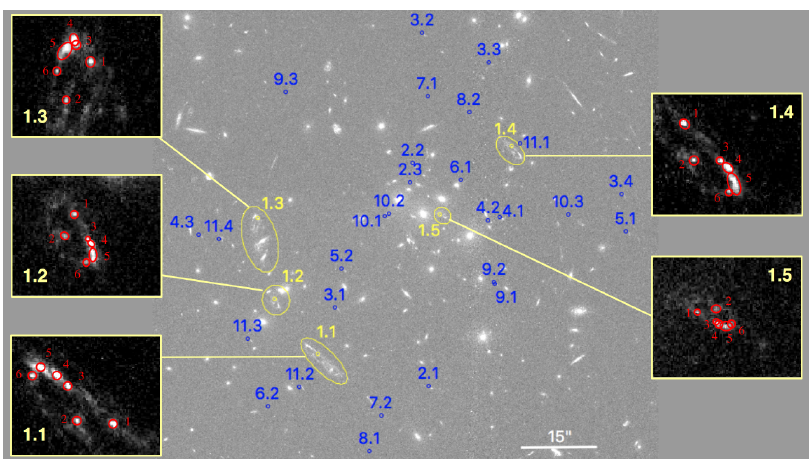
Figure 3. Galaxy cluster CL0024 and its multiple-image sets (MISs): MIS 1 (yellow ellipses) with five images with six reference points each (red circles in image details) to apply our approach as described in Section 2.3 and with MISs 2 to 11 (blue points) as predicted by [91], but not spectroscopically confirmed. MIS 3, 4, 5, 8, and 10 were used to set up lens models that were compared to the model-independent approach. Image credits: